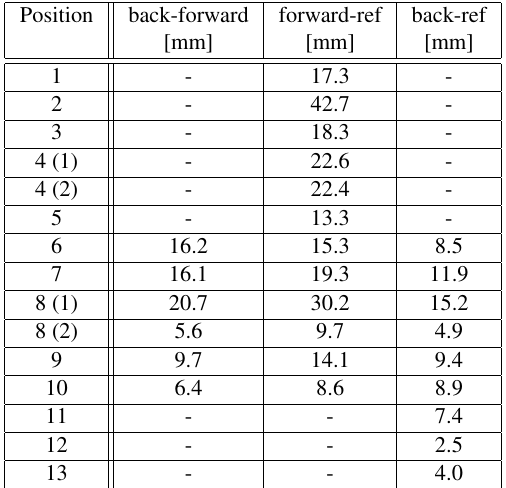
Table 1: Differences at pole centers. (back-forward): between the opposite scanner directions at same position. (forward-ref) and (backward-ref): between reference and estimated scanner posi- tion. (1) and (2) indicate positions 4 and 8 as turning points with four possible